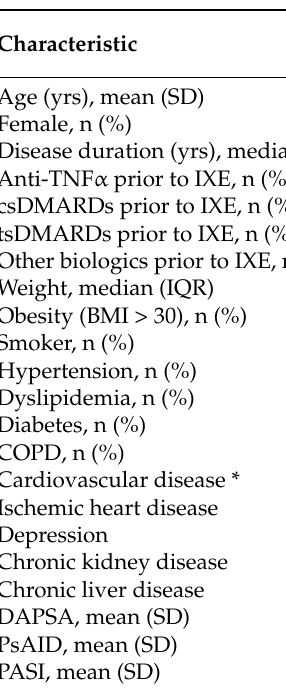
Table 1. Main disease characteristics of the study